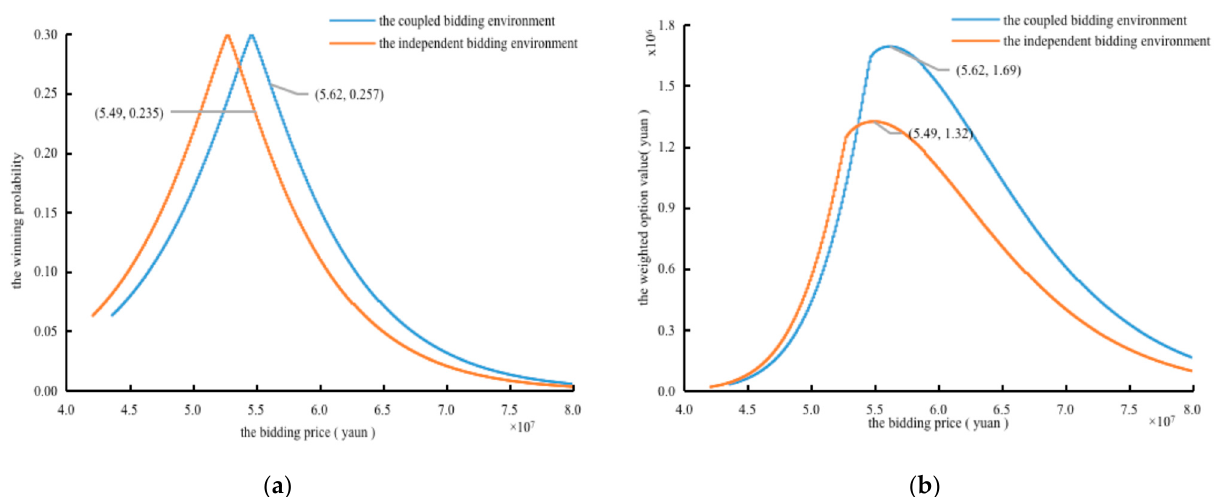
Figure 9. The optimal price decision comparison. ( a ) Fluctuation trend of the winning probability; ( b ) Fluctuation trend of the weighted option value.